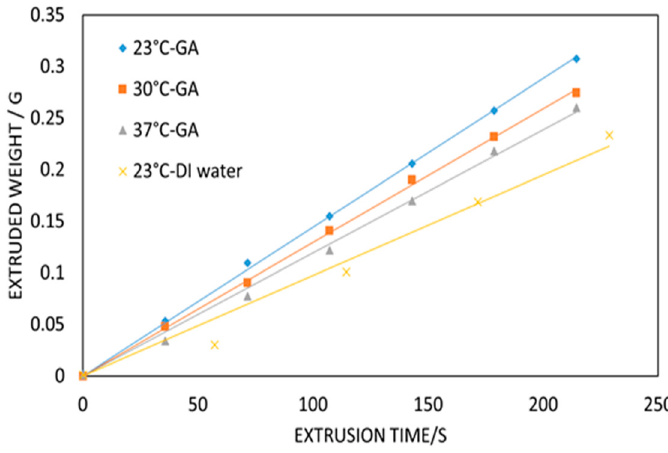
Figure 3. The effect of process temperature on extrusion rate of gelatin-alginate (GA) with comparison to DI